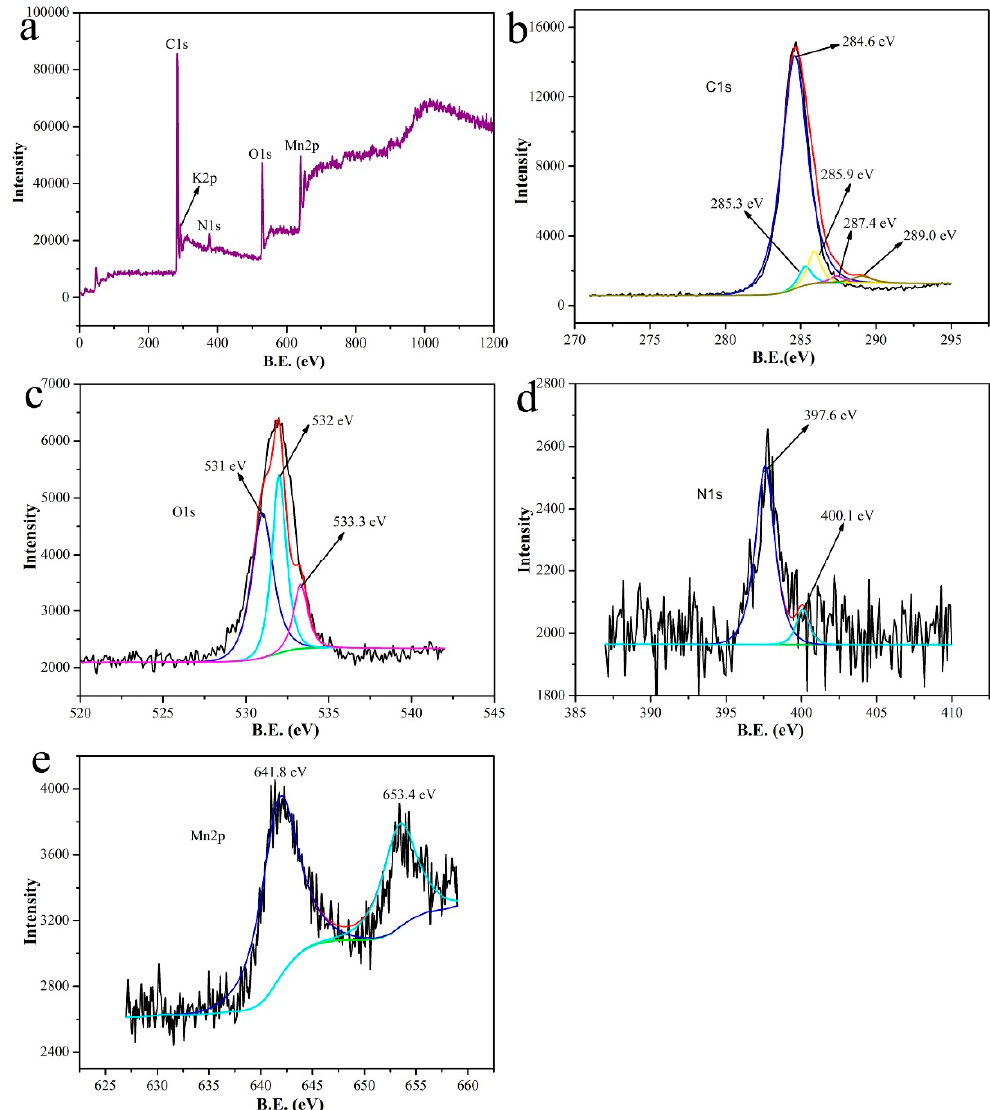
Figure 5. XPS spectra of MnO-4: ( a ) full-scan spectrum, ( b ) C 1s spectrum, ( c ) O 1s spectrum, ( d ) N 1s spectrum, and ( e ) Mn 2p spectrum.